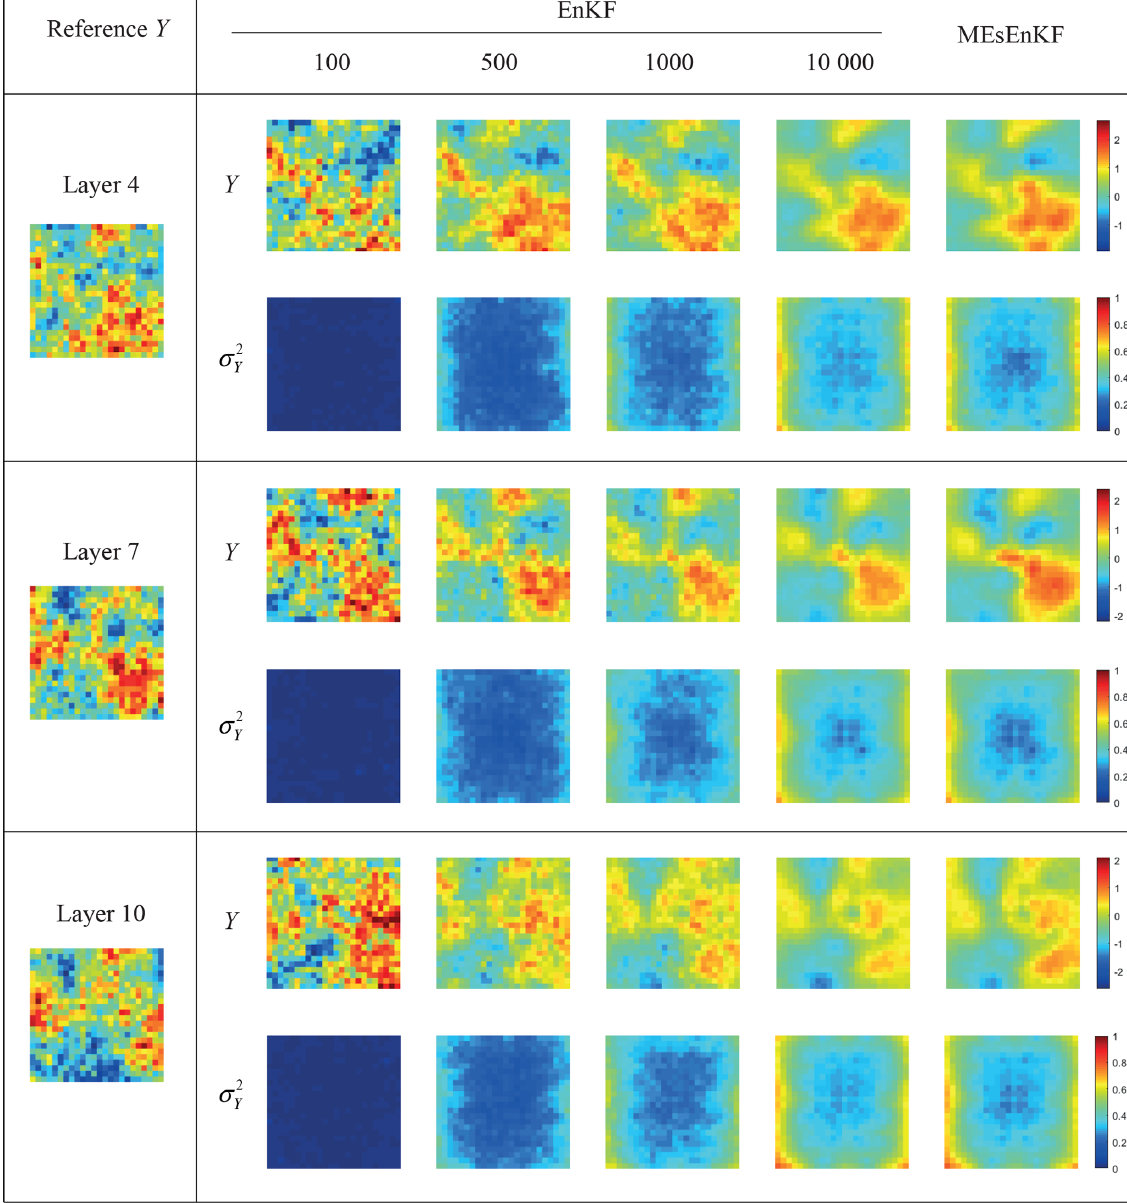
Figure 4. Reference Y field (left column) and estimates of the mean and variance of Y at the end of the assimilation process across layers 4, 7, and 10 for TC1. Results computed via the MC-EnKF (with 100, 500, 1000, and 10000 realizations) and MEs-EnKF are